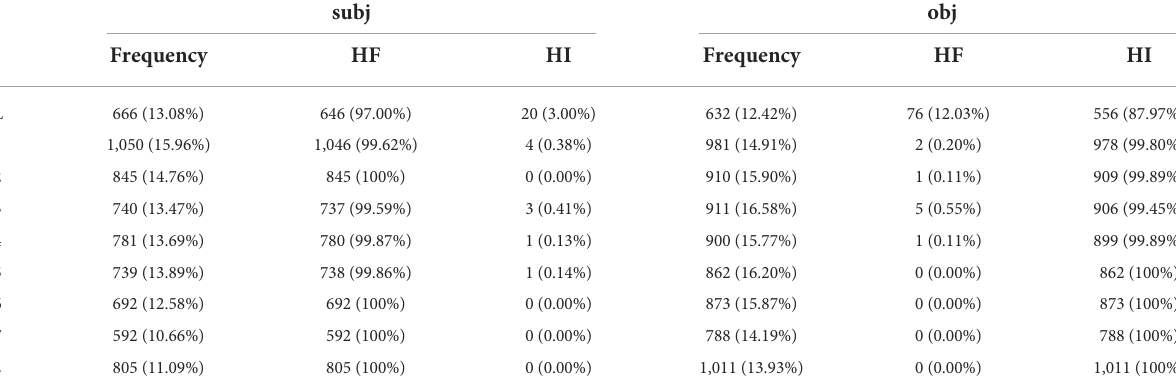
TABLE 4 In spoken modality, frequencies and dependency direction distributions of subjects and objects at each level and in contrastive